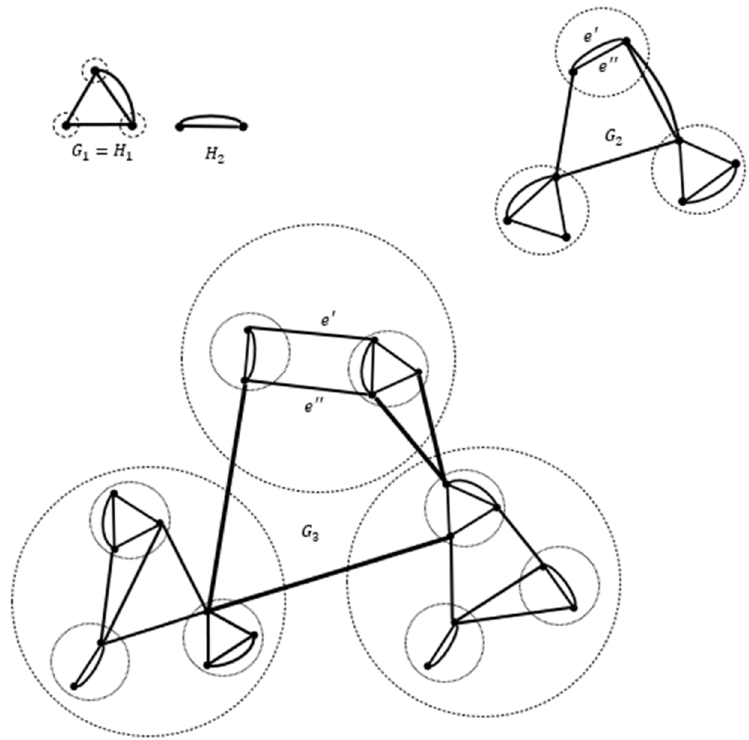
Figure 7. Multigraph G 3 generated by a set H = { H 1 , H 2 }